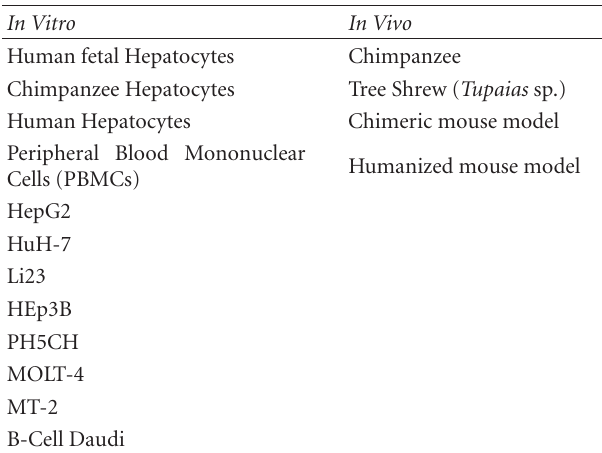
Table 1: In vitro and in vivo models to study HCV. In Vitro In Vivo Human fetal Hepatocytes Chimpanzee Chimpanzee Hepatocytes Tree Shrew ( Tupaias sp.) Human Hepatocytes Chimeric mouse model Peripheral Blood Mononuclear Humanized mouse Cells (PBMCs)